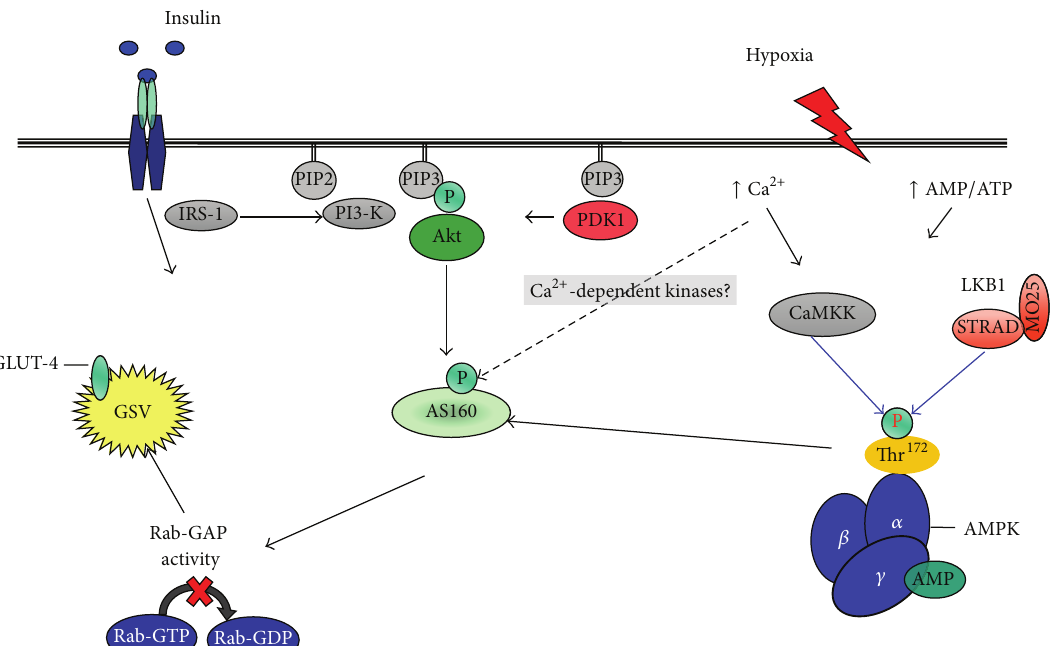
Figure 1: Insulin and contraction signaling pathways during GLUT-4 recruitment and translocation. Adapted from Mackenzie and Elliott [60]. IRS, insulin receptor substrate; PI3-K, class IA phosphatidylinositol 3-kinase; PIP2, phosphatidylinositol 4,5-bisphosphate; PIP3, phosphatidylinositol 3,4,5-trisphosphate; PDK1, phosphoinositide-dependent protein kinase-1; Akt, serine/threonine protein kinase; AS160, 160kDa Akt substrate; GLUT-4, glucose transporter 4; GSV, GLUT-4 storage vesicle; Rab-GAP, Rab-GTPase-activating protein; Rab-GDP, guanosine-50-diphosphate-loaded Rab; Rab-GTP, guanosine-50-triphosphate-loaded Rab; CaMKK, Ca 2+ /calmodulin-dependent protein kinase kinase; LKB1, serine/threonine kinase 11; STRAD, putative kinase; MO25, mouse protein 25/scaffold protein; AMPK, 5 󸀠 - monophosphate-activatedproteinkinase;Thr 172 ,phosphorylatedAMPK 𝛼 atthreonine172;AMP,adenosinemonophosphate;ATP,adenosine triphosphate; P, phosphorylated